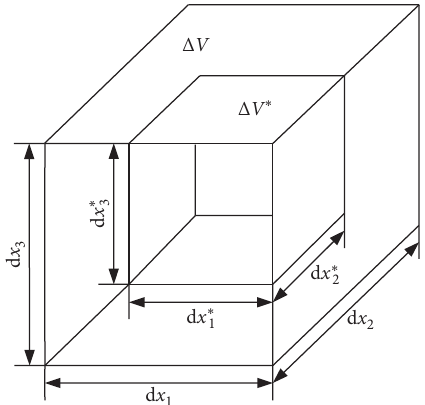
Figure 8: Diagram of a damaged